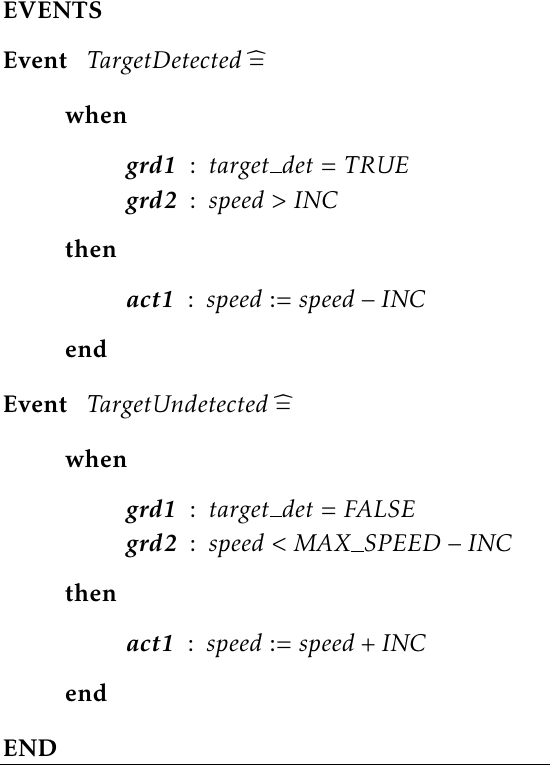
Figure 6. Events with strengthened guards